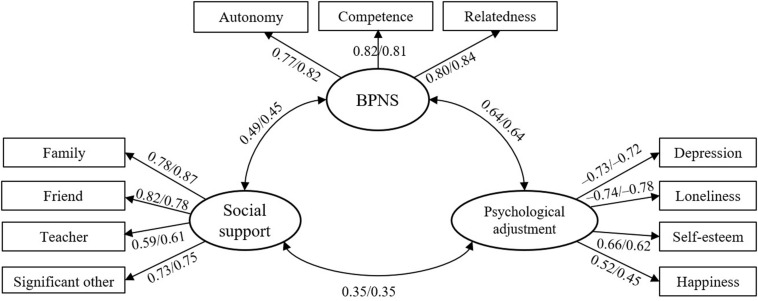
Measurement model among all latent variables. The values before and after the slash “/” denote the path coefficients of LBC and NLBC, respectively, the same below. Model fitting: χ2/df = 4.88/2.05 and RMSEA = 0.075/0.063.